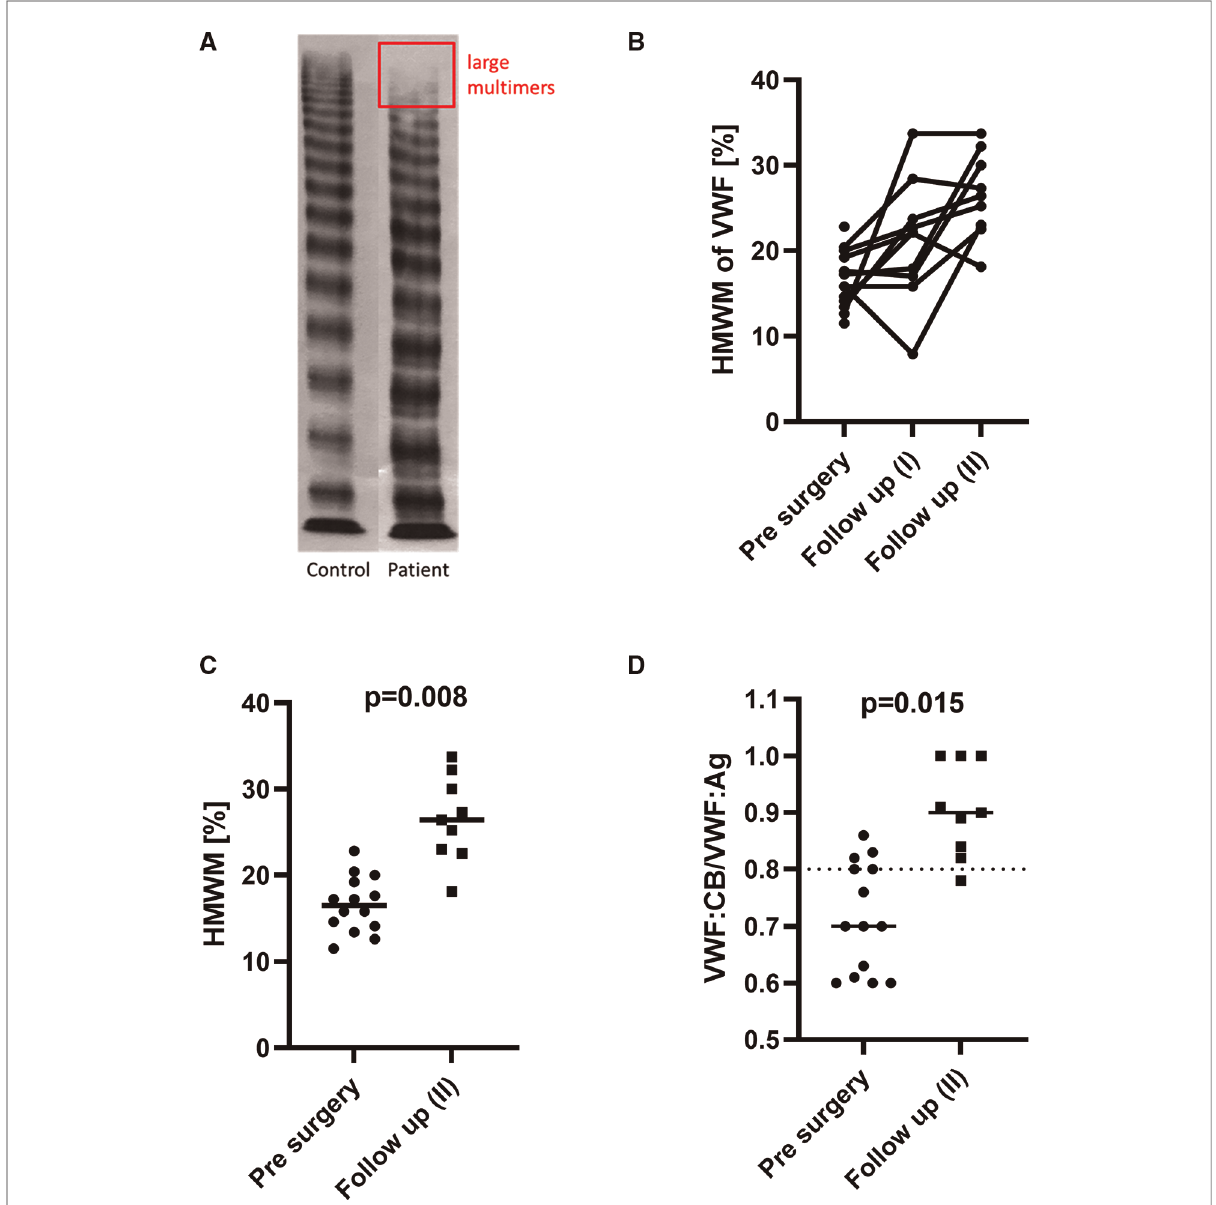
FIGURE 3 An exemplary multimer analysis ( A ) of the plasma of one shunt patient (No. 11) with a complete loss of the largest multimers (the rectangle corresponds to the typical area of distribution of HMWM on gel electrophoresis; the full gel was cropped for the sake of clarity). The individual course of every patient is presented in ( B ) and shows gradual HMWM recovery following shunt excision surgery for most patients. The HMWM values ( C ) and also the ratio VWF:CB/VWF:Ag ( D ) increased signi fi cantly after shunt